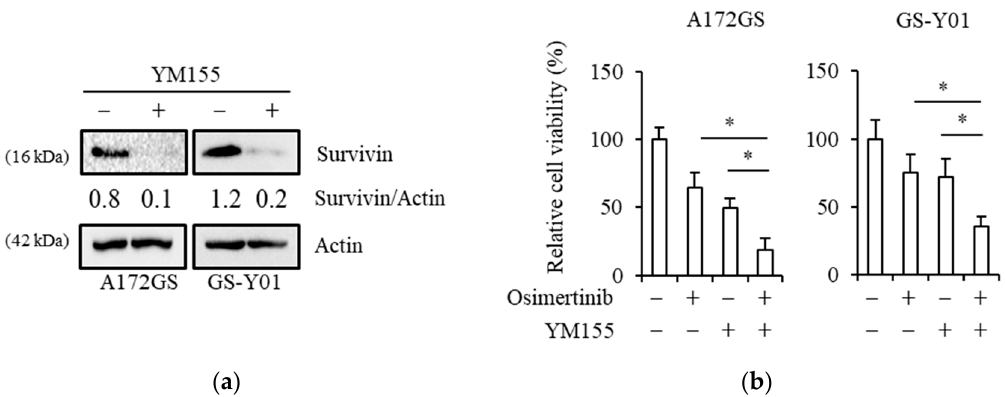
Figure 2. Pharmacological inhibition of survivin by YM155-induced sensitization of GSCs to osimertinib: The indicated GSCs were treated with or without 10 nM of YM155 and with or without 1.5 µ M of osimertinib for 3 days. ( a ) The cells (with or without YM155 only) were subjected to immunoblot analysis for survivin protein expression. ( b ) The cells were then subjected to cell viability assay using WST-8. Values represent means +SD from quadruplicate samples of a representative experiment repeated with similar results. * p < 0.05.